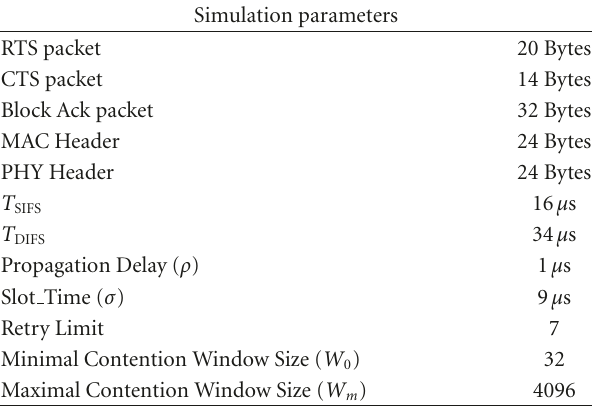
Table 2: System parameters for performance